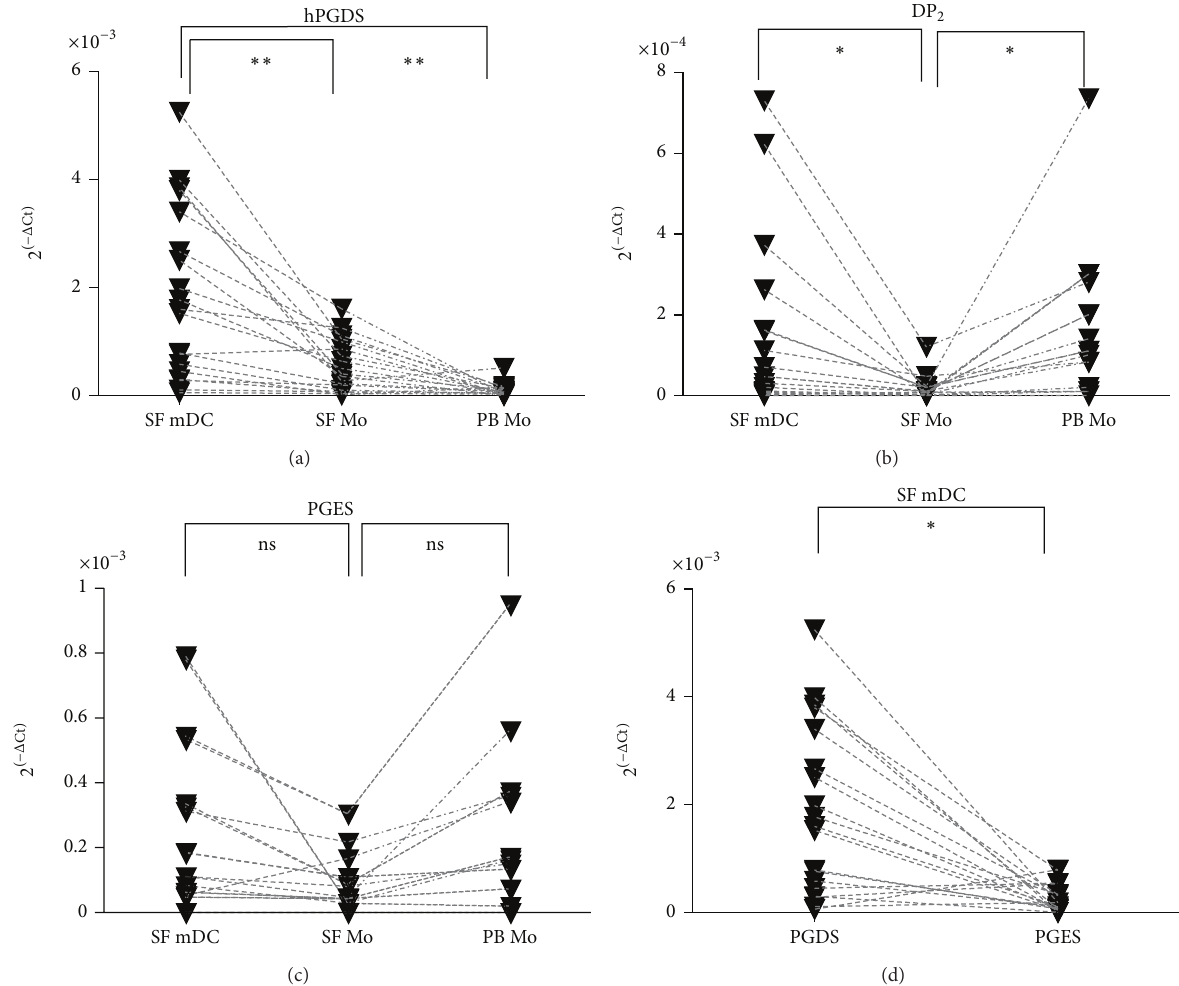
Figure 3: Expression of mRNA for (a) hPGDS, (b) PGD receptor DP 2 , (c) PGES in SF myeloid DC, SF monocytes, and PB monocytes, and (d) hPGDS versus PGES in SF mDC in patients with inflammatory arthritis. ∗ 𝑃 < 0.01 , ∗∗ 𝑃 < 0.0001 , ns: not